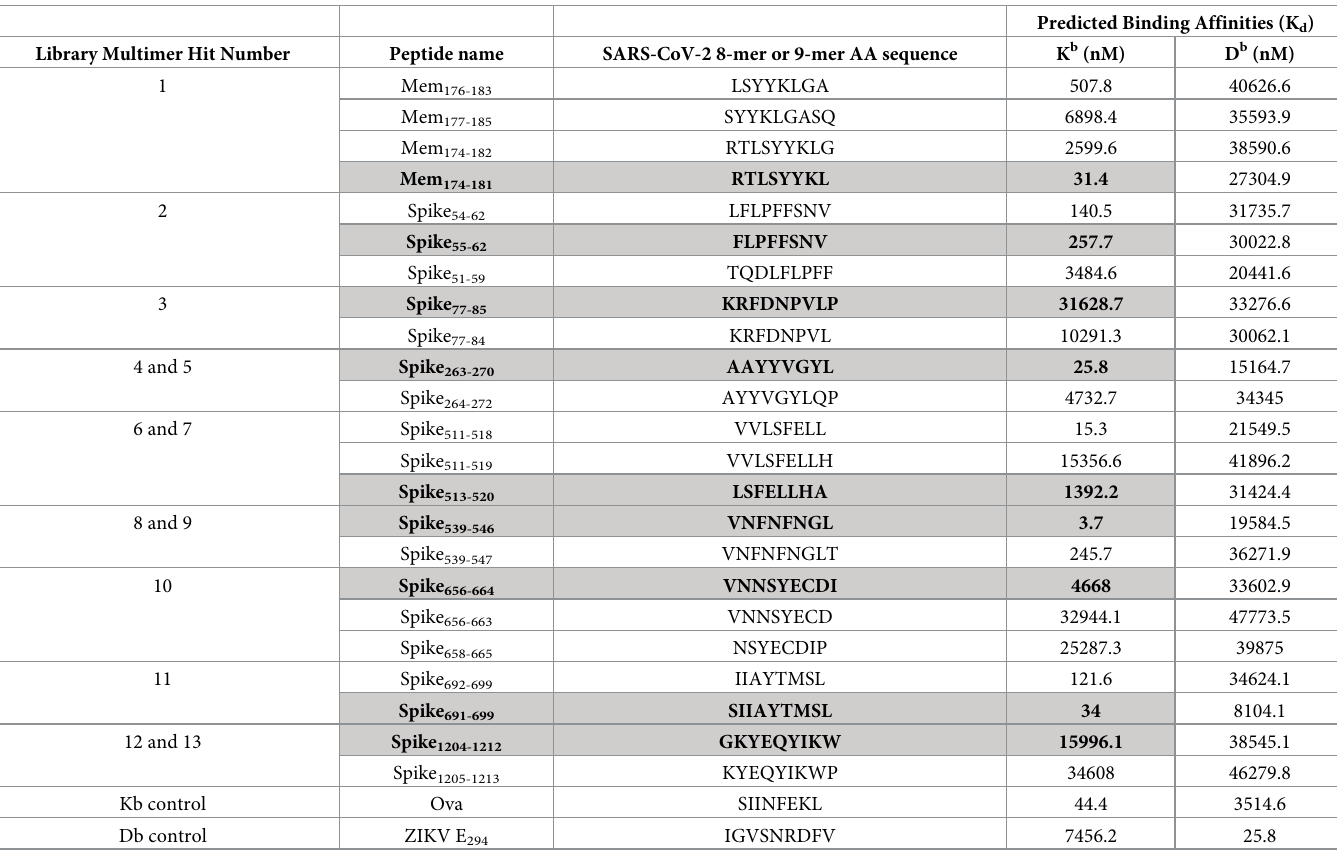
Table 3. Optimal 8-mer and 9-mer SARS-CoV-2 epitope identification. Based on the analogous SARS-CoV-2 peptide library sequences. Peptide sequences are named based on the protein they are contained within, followed by the number of the first amino acid residue of the peptide in the context of the full protein, to the last amino acid residue. potential optimal 8-mer or 9-mer CD8+ T cell epitopes were predicted. To determine the predicted binding affinities of the putative SARS-CoV-2 8-mer or 9-mer CD8+ T cell peptide epitopes to MHC class I, using the NetMHCpan 3.0 server, which uses artificial neural networks to predict relative binding affinities of peptides to any Kb or Db. As controls for strong Kb and Db binders respectively, Ova peptide and ZIKV E294 were input into the same algorithm. Optimal peptide epitopes are highlighted based on functional T cell data in combination with RMA-S stabilization assay